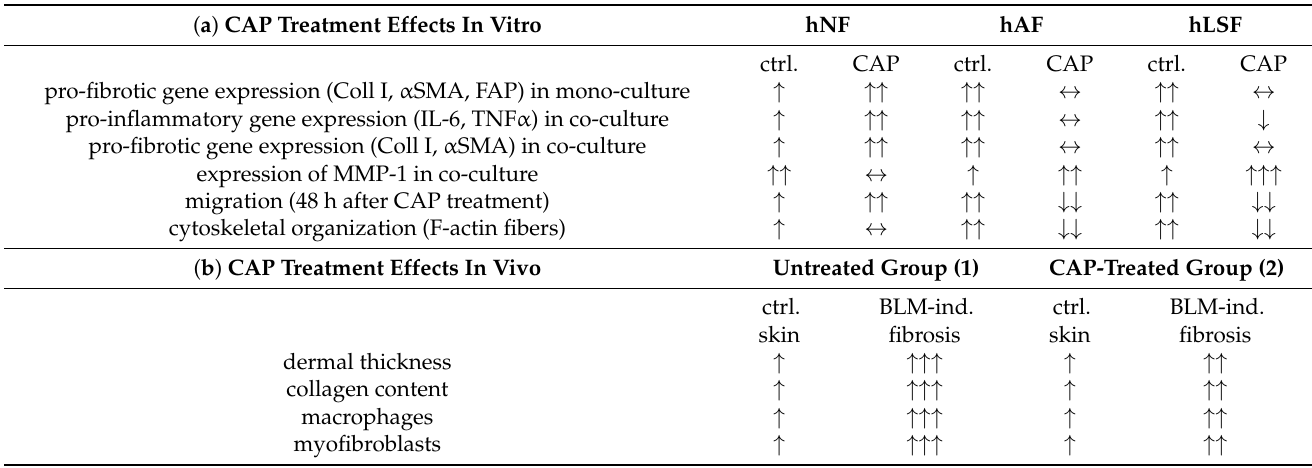
Table 2. Overview of CAP treatment effects on hNF, hAF, hLSF and BLM-induced fibrosis. ( a ) CAP Treatment Effects In Vitro hNF hAF hLSF ctrl. CAP ctrl. CAP ctrl.